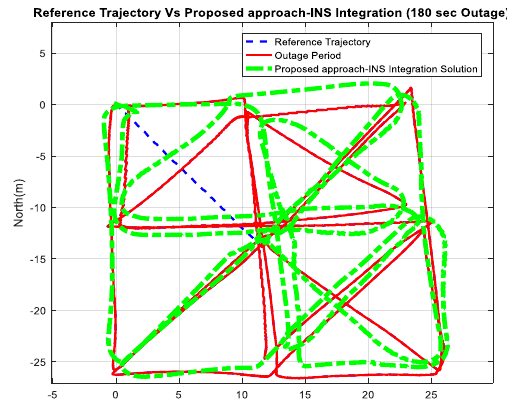
Figure 15. Performance of the proposed approach (camera and UWB) integrated with INS, with lower UWB system infrastructure for a complete 3-minute GNSS signal outage (configuration f )